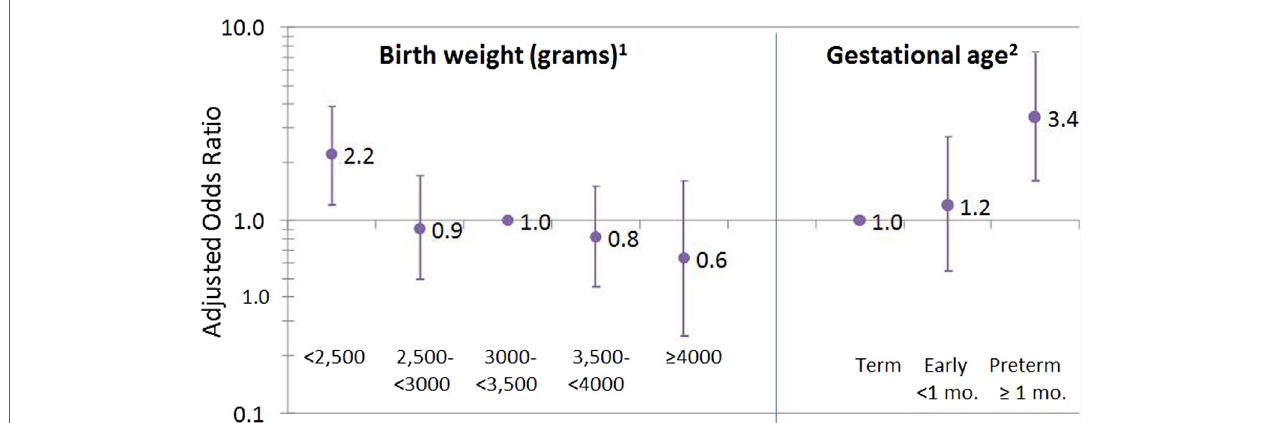
FigUre 1 | Birthweight and gestational age associated with sle . 1 Missing on 39 cases (31%) and 13,659 (27%) non-cases; test for trend across birthweight categories, p = 0.008. 2 Missing or do not know for 67 cases (54%) and 27,681 (55%)